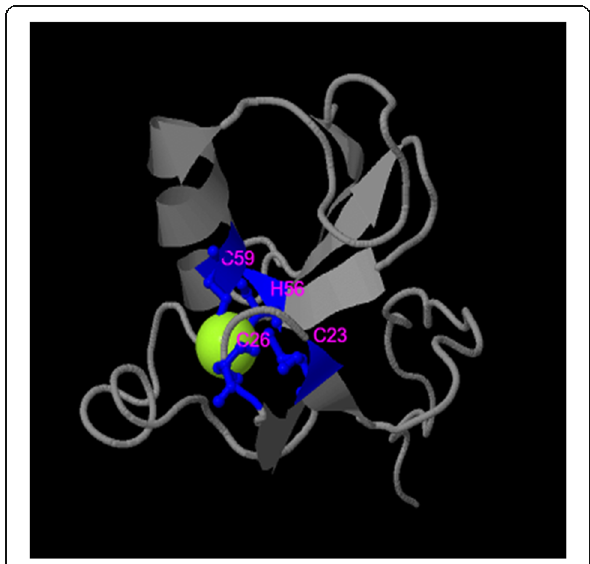
Fig. 6 Ligand binding site prediction of EhApc11. COACH output indicates that zinc binds to a cysteine residue at positions 23, 26, and 59 and with a histidine residue at position 56 with a C -score of 0.75. Range values of C -score prediction lie between 0 and 1, where the highest score indicates more reliability